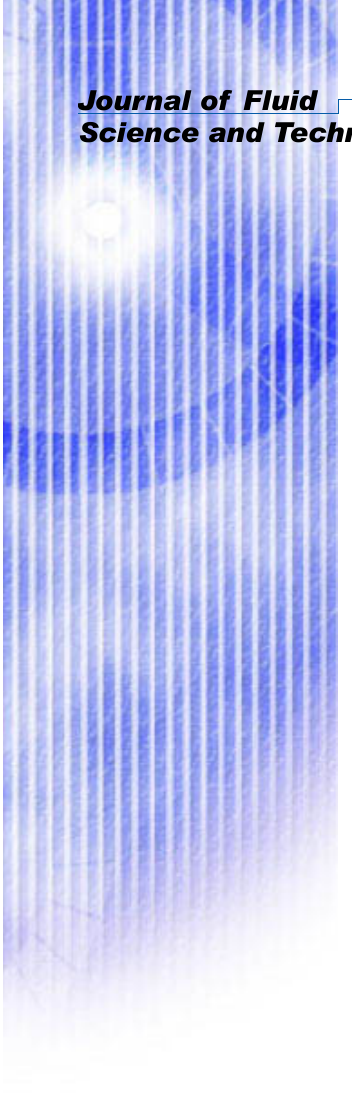
Fig.8 Effect of the axial distance on the output characteristics